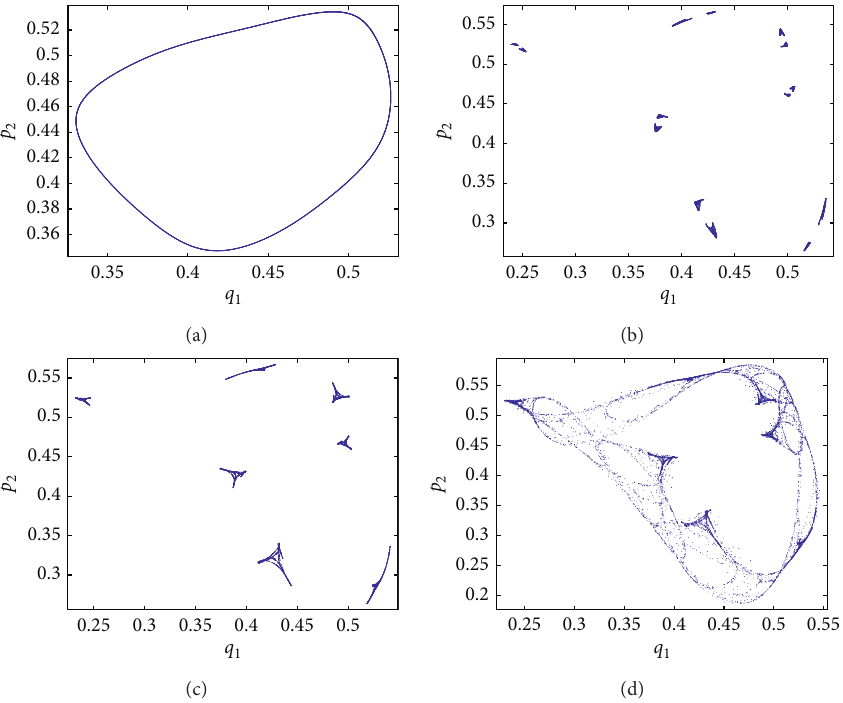
Figure 6: The strange attractors of the system when d � 0 . 2. (a) α � 2 . 5 , β � 2 . 1. (b) α � 2 . 5 , β � 2 . 6. (c) α � 2 . 5 , β � 2 . 614. (d) α � 2 . 5 , β � 2 . 615.